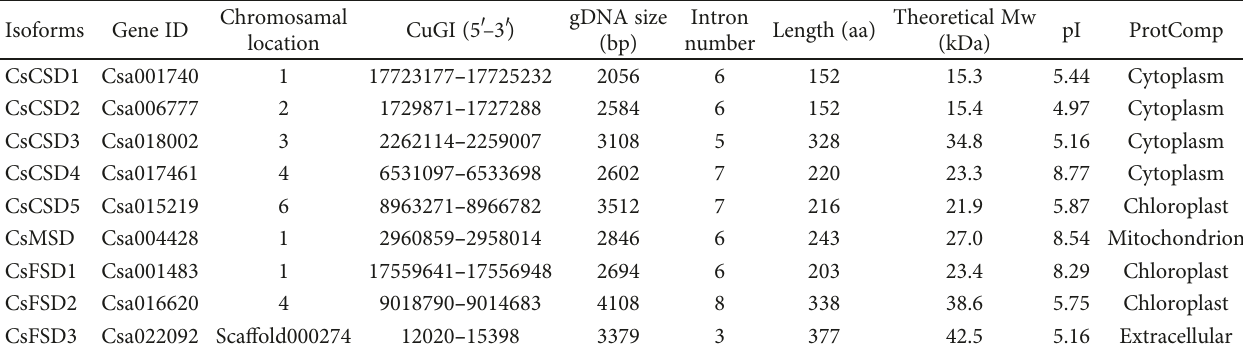
Table 1: A complete list of 9 CsSODs identi fi ed in this